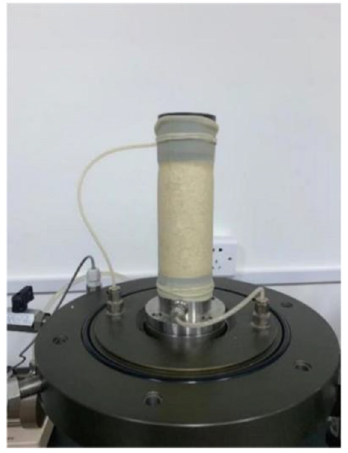
Figure 5. Sample preparation. Figure 5. Sample